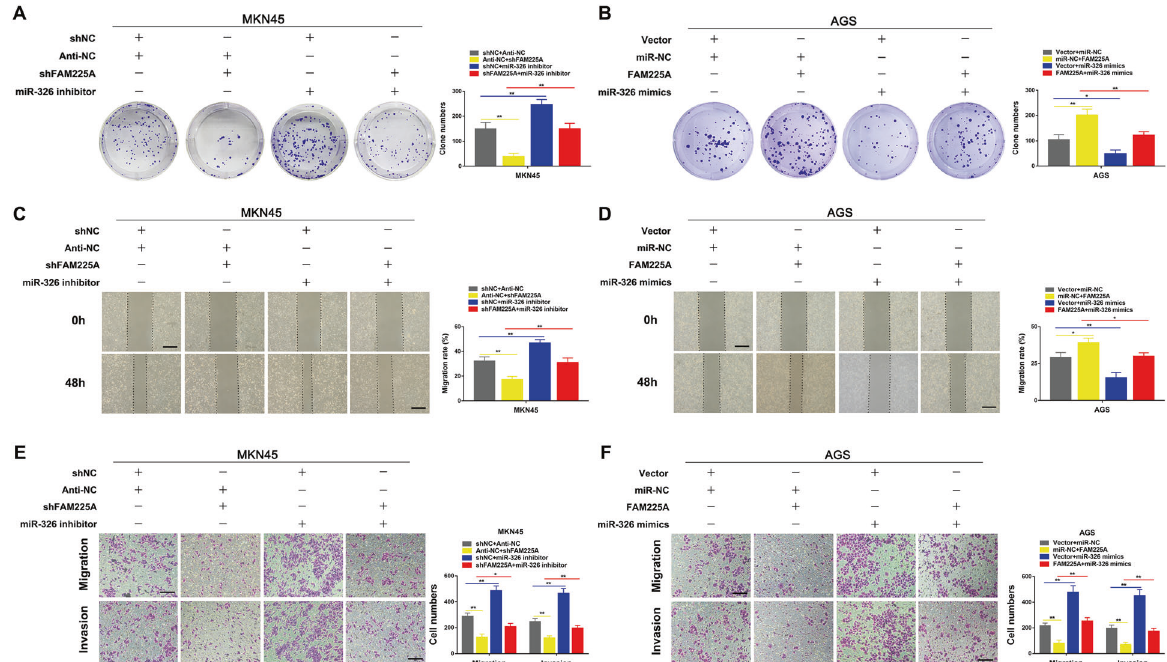
Fig. 5 The functional effects of FAM225A can be regulated by miR-326 in GC. A , B Colony formation assays was used to detect the cell proliferation ability after transfecting MAN45 cells with negative control, shFAM225A, miR-326 inhibitor or shFAM225A + miR-326 inhibitor, and transfecting AGS cells with negative control, FAM225A, miR-326 mimics or FAM225A + miR-326 mimics. C – F The wound healing assays and transwell assays were used to detect the cell migration and invasion ability after transfecting GC cells (scale bar: 100 μ m for wound healing assay, 200 μ m for transwell assay). p values were obtained by Student ’ s t test. Data are presented as means ± SD. * p < 0.05, ** p <